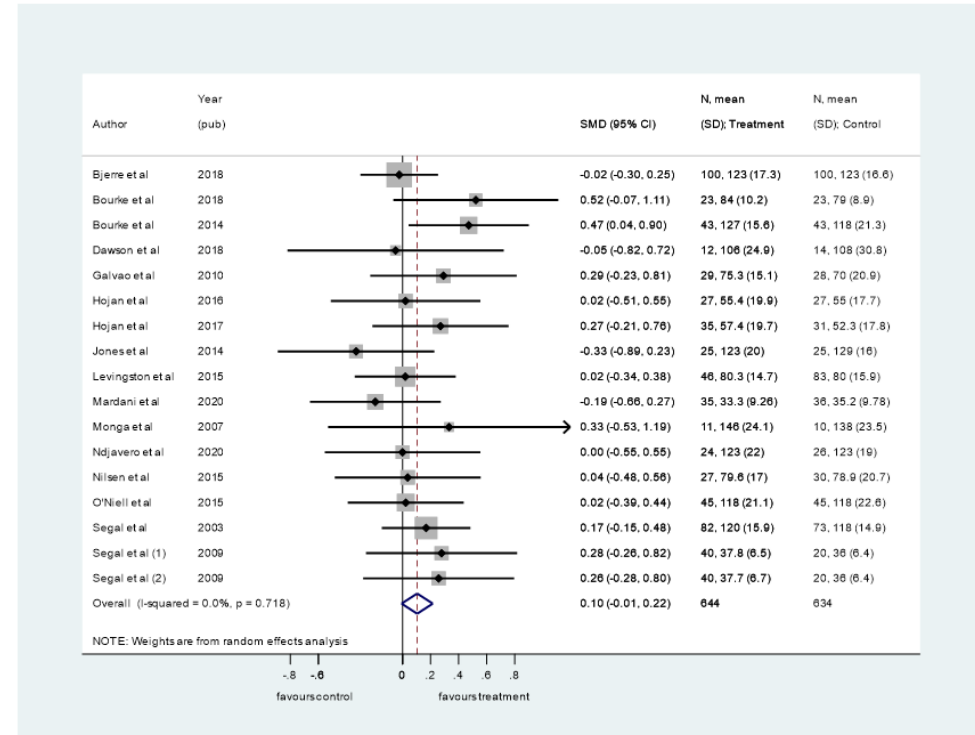
Figure 2. Pooled standard mean difference (SMD) on cancer-specific quality of life comparing exercise interventions with usual care or control in men with prostate cancer. A random effects model of DerSimonian and Laird, with estimate of heterogeneity from the Mantel–Haenszel model was used.